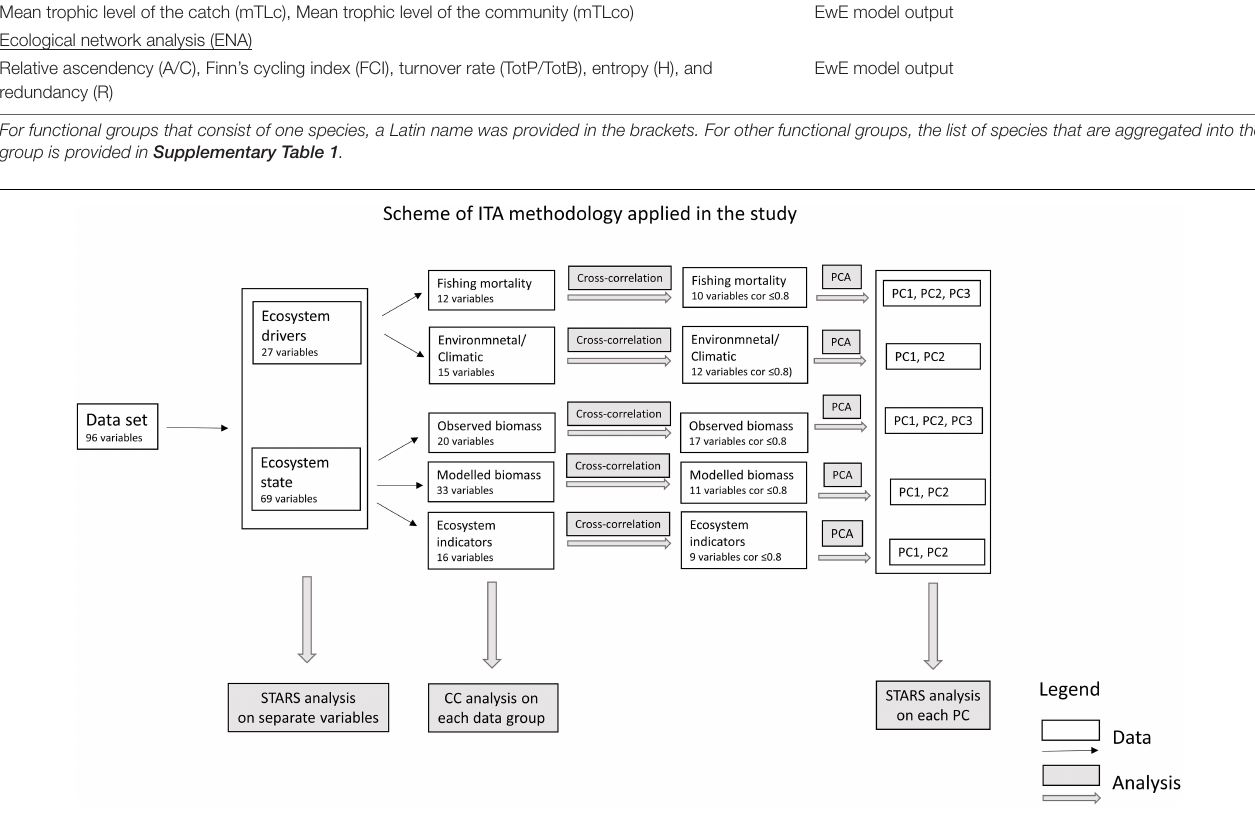
FIGURE 2 | Scheme of integrated trend analysis (ITA) methodology applied in this